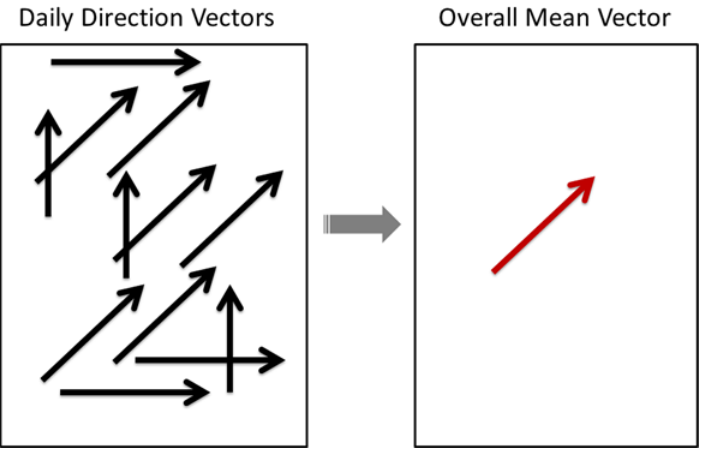
Fig 1. Graphic depiction of ArcGIS linear directional mean function. The ArcGIS linear directional mean function converts the mean daily vectors for direction and distance of virus spread (left) into a single vector that indicates the mean direction and mean distance of virus spread over